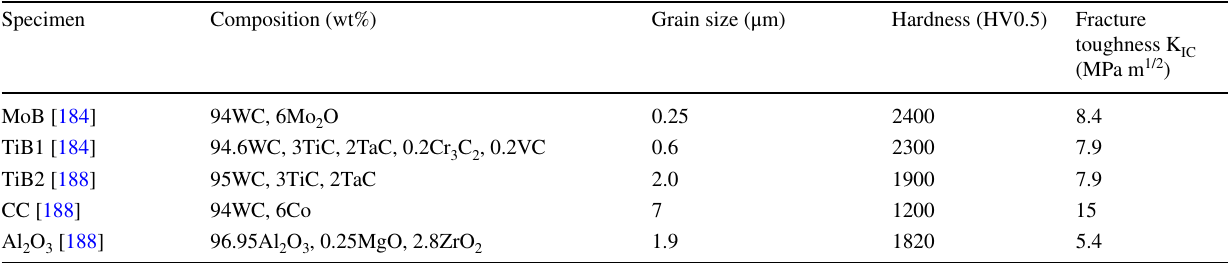
Table 8 Composition, grain size, hardness and fracture toughness of the tested materials